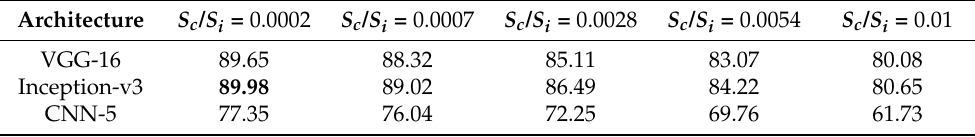
Table 2. Dependence of the proportion of correct recognitions on the size of the distorted area.